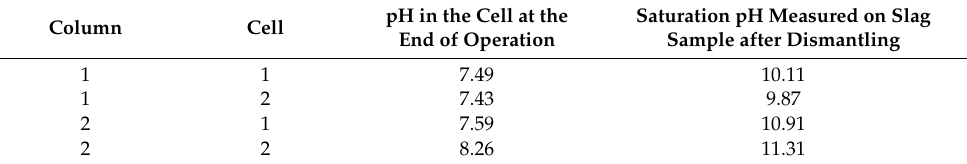
Table 3. Slag exhaustion at the end of column experiments.